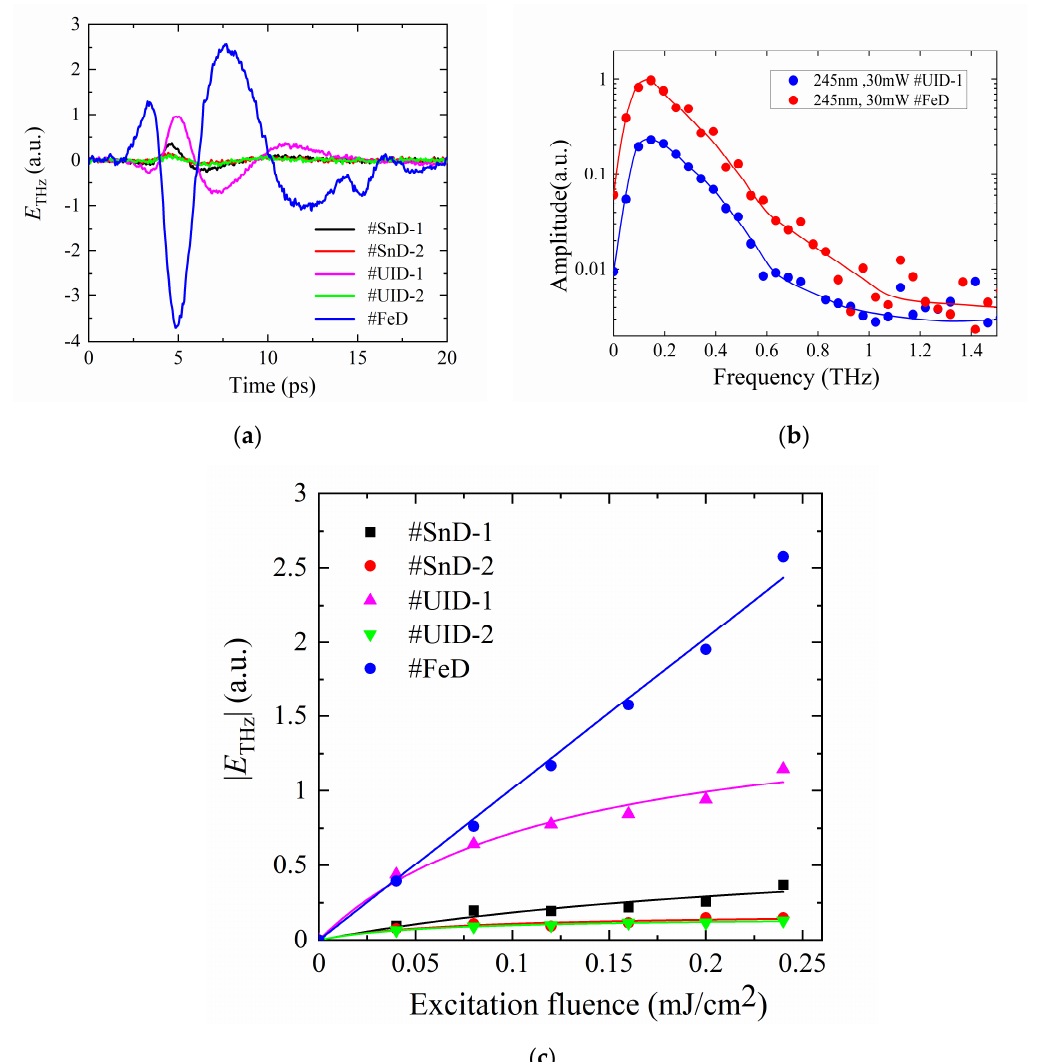
Figure 3. ( a ) Time-domain waveforms of THz amplitude ( E THz ) excited at 245 nm and corresponding Fourier spectra for #UID-1 and #FE at a laser power of 30 mW. ( c ) The laser power dependence of the intensity of E THz with fits to the data. The intensity is defined at the maximum point of the waveforms at around 5 psec. The lines in ( b ) are eye guides.